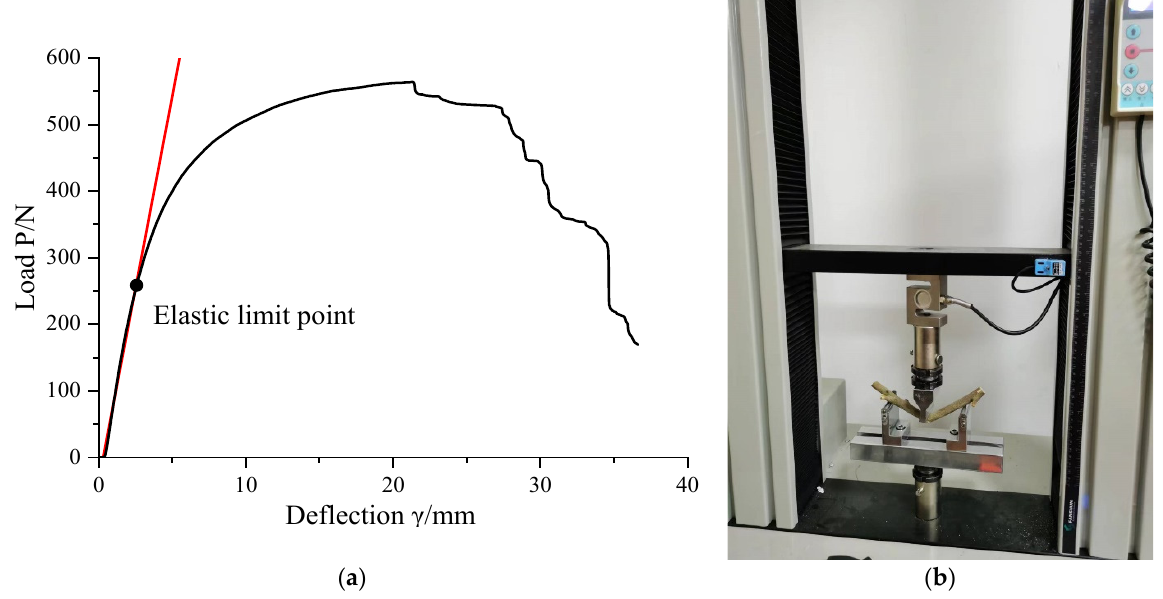
Figure 2. Three-point bending test. ( a ) Load displacement curve; ( b ) Test photo.